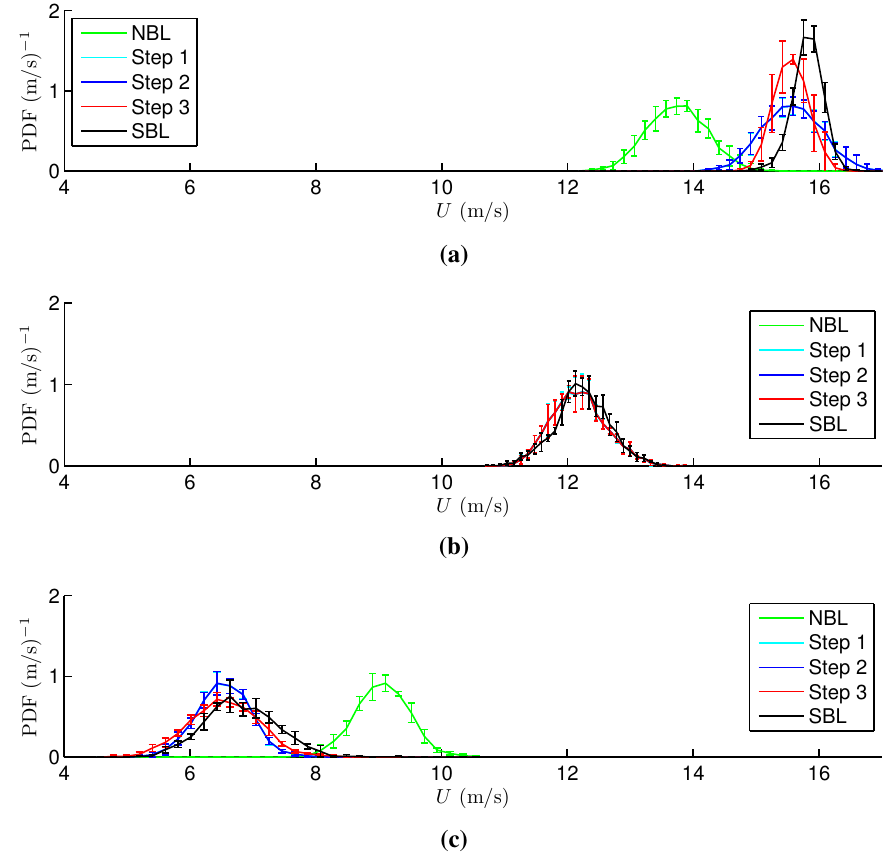
Figure 18. Probability density functions for the longitudinal wind velocity, U , for a single case (control). ( a ) Rotor top; ( b ) Rotor hub; ( c ) Rotor